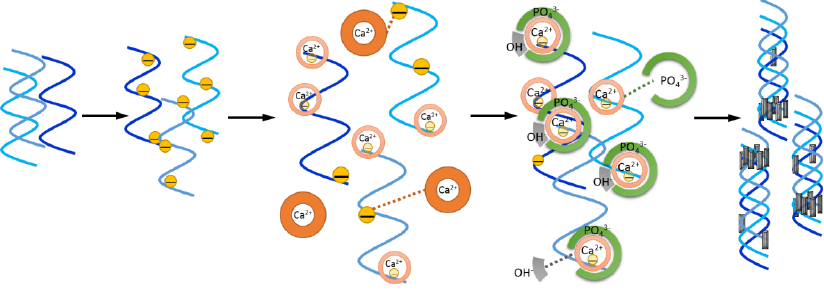
Figure 2. Schematic illustration of the biomimetic mineralization process of nHap/Col composite.